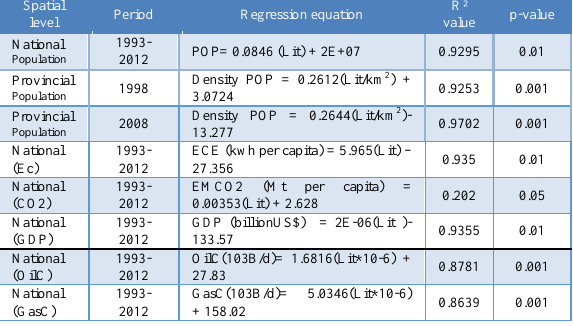
Table 3. Regression Equations for Estimating Socioeconomic by using the Lighted area (Lit) from DMSP-OLS data. The relationship between nighttime light and